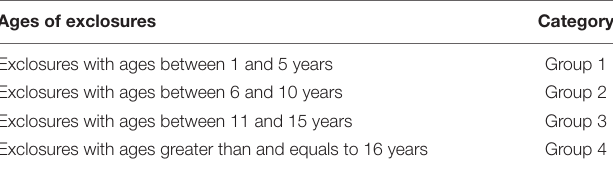
TABLE 1 | Categories of exclosures established at different time periods.